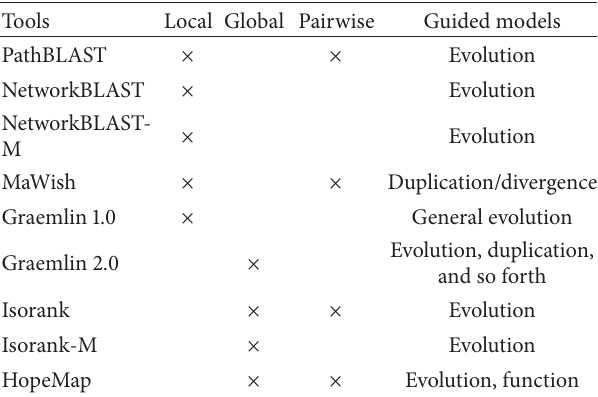
Table 1: A summary of classification of different network alignment